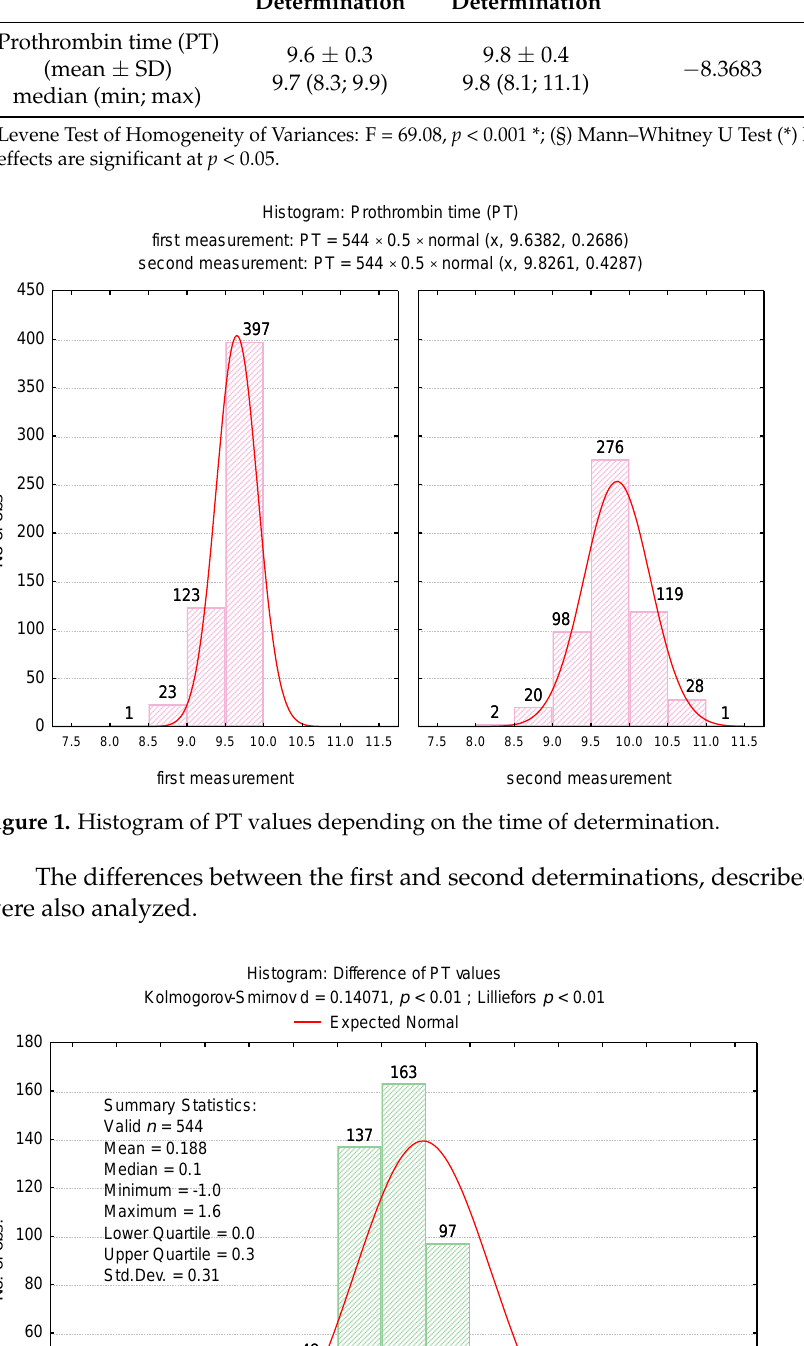
Table 2. Evaluation of hypercoagulability according to the second determination. ( n = 544) Categ. Box & Whisker Plot: Difference of PT values Kruskal-Wallis-H (2,544) = 397.813, p < 0.001